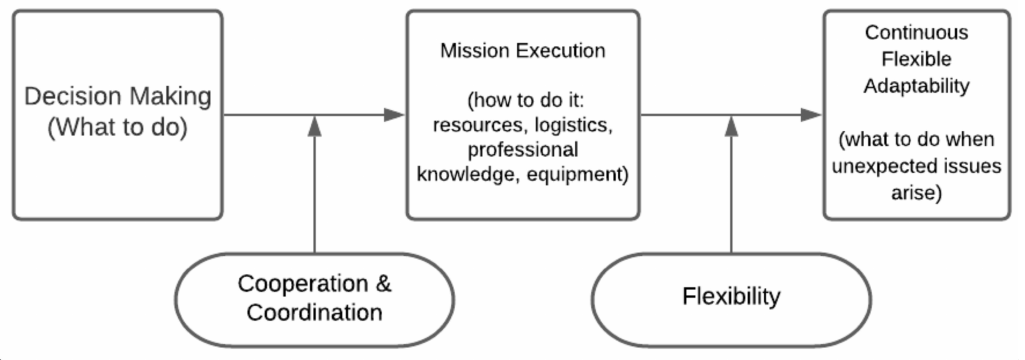
Figure 1. Components of emergency response during